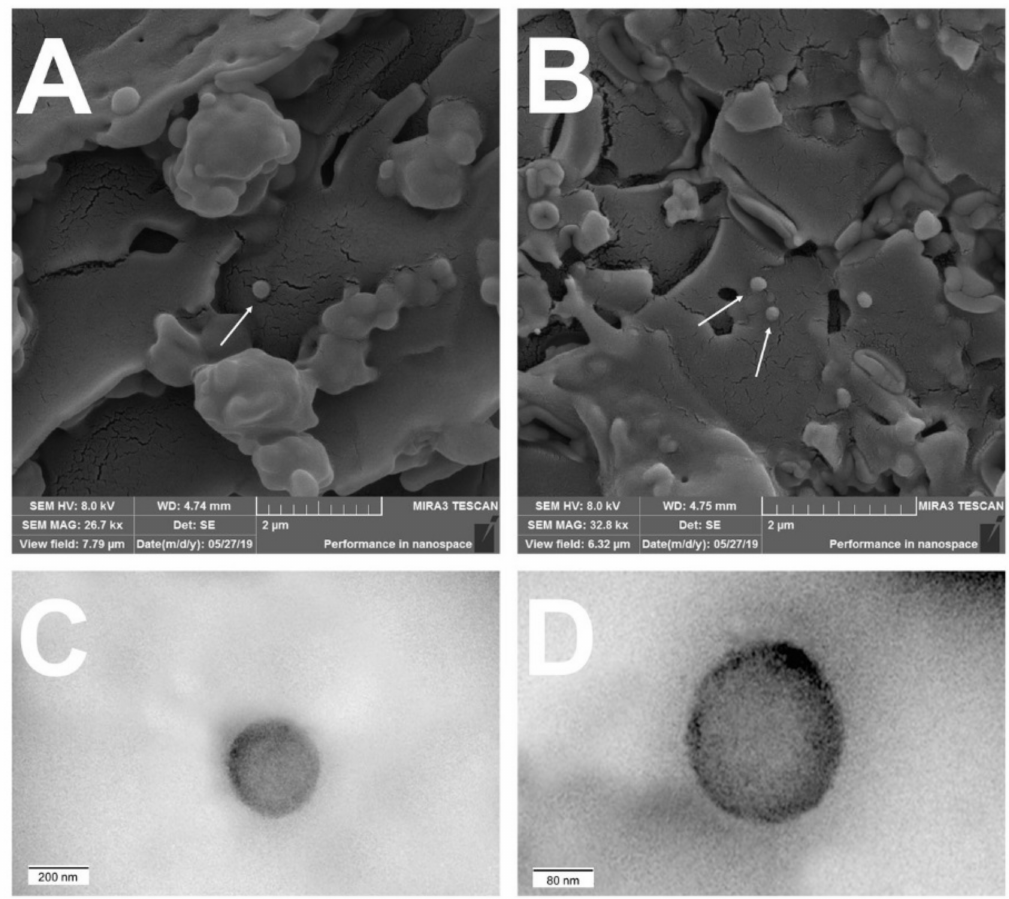
Figure 2. FESEM images of non-loaded and TAC-loaded nanocapsules: ( A ) NC-N at 26,700 × magnification and ( B ) NC-1 at 32,800 × magnification. TEM images of non-loaded and TAC-loaded nanocapsules: ( C ) NC-N at 25,000 × magnification and ( D ) NC-1 at 62,500 ×